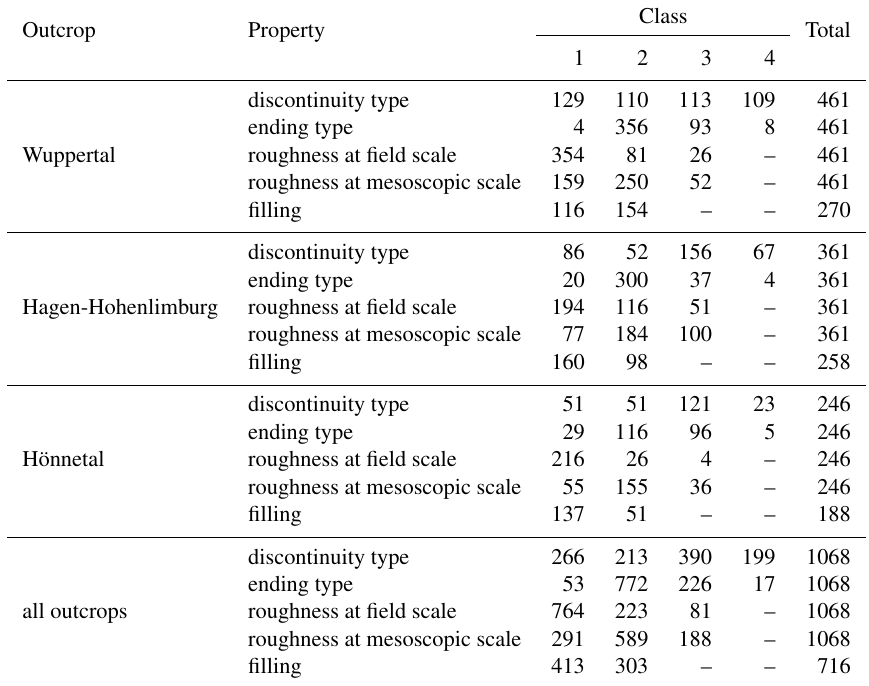
Table 2. Overview of the recorded properties and their classification of the measured discontinuities in the three studied outcrops in Wup- pertal, Hagen-Hohenlimburg, and Hönnetal. See the text and Table 1 for a detailed description of the classes.